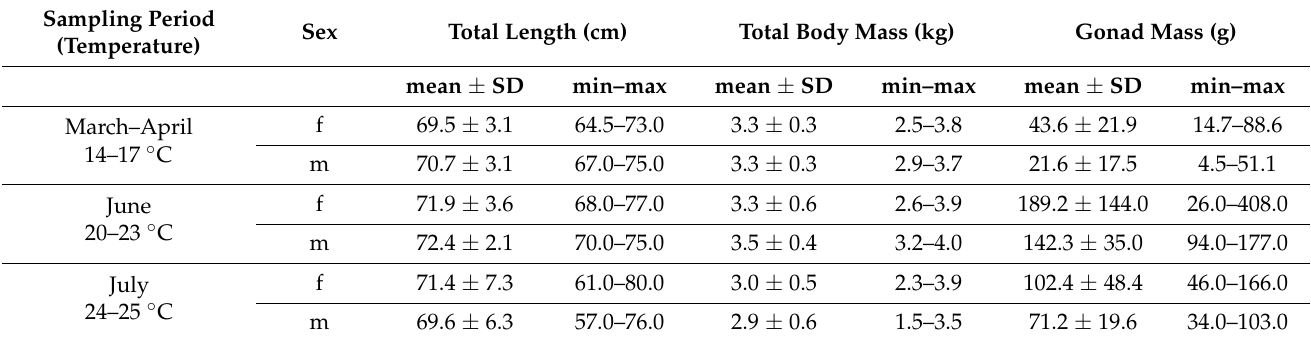
Table 1. Biometric data of meagre reared in floating sea cages in the Gulf of Taranto (North Ionian Sea). Sampling